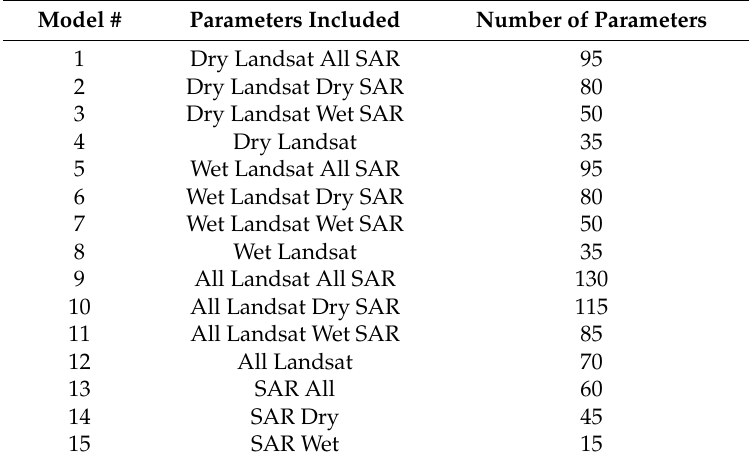
Table 3. The 15 independent models tested in this study and the number of parameters in